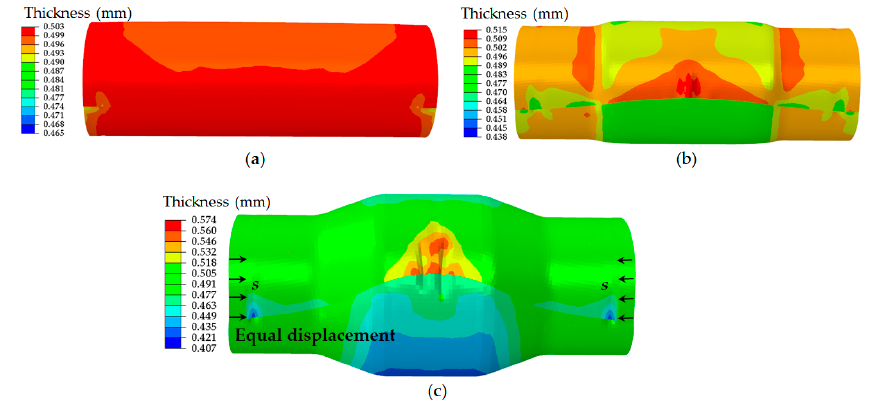
Figure 10. Hydroforming of overlapping blank with tied ends ( a ) p = 2.0 MPa; ( b ) p = 5.0 MPa; ( c ) p = 9.0 MPa.